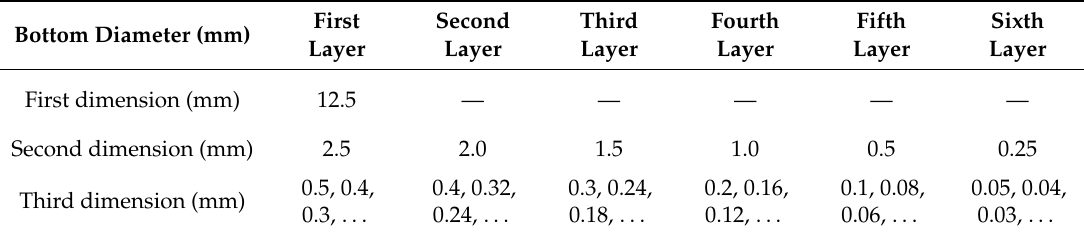
Table 3. Diameter of the convex hull.